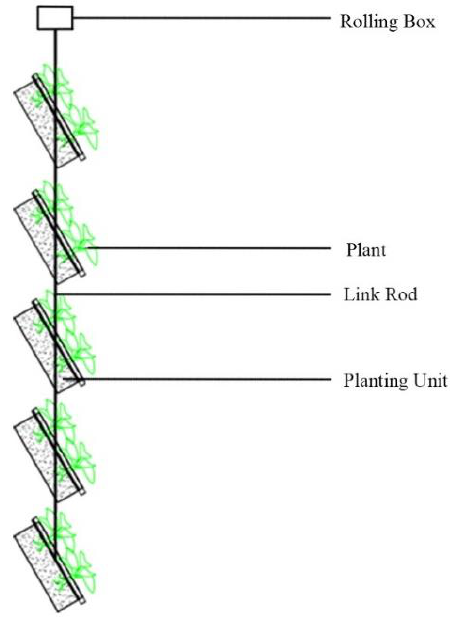
Figure 2. Simplified shading model of MVGSD.